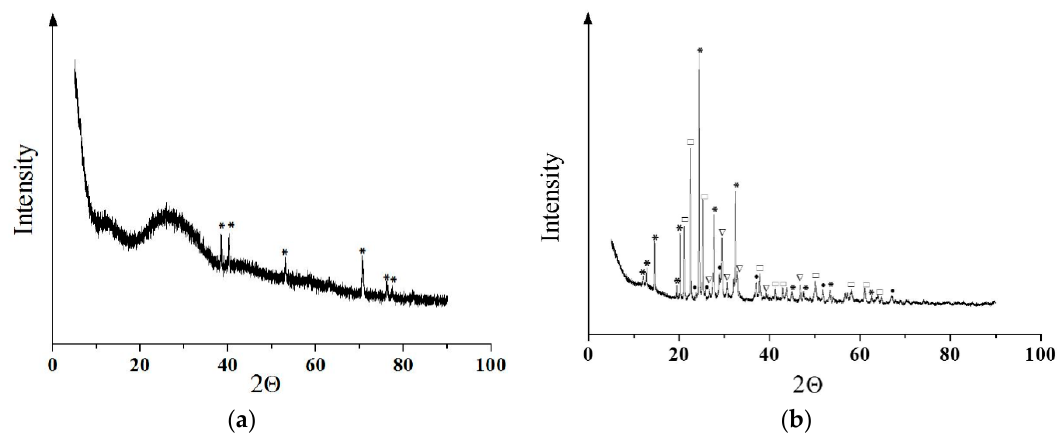
Figure 3. Diffractograms of the CP coating on a titanium surface obtained using the microarc oxidation (MAO) method. ( a ) The amorphous halo from the CP coating and the peaks from the titanium substrate; ( b ) the calcium phosphate coating after annealing at 1073 K. Peaks correspond to the phases: * – CaTi 4 (PO 4 ) 6 , □ – TiP 2 O 7 , ▽ – β -Ca 2 P 2 O 7 , and ● – TiO 2 (anatase).